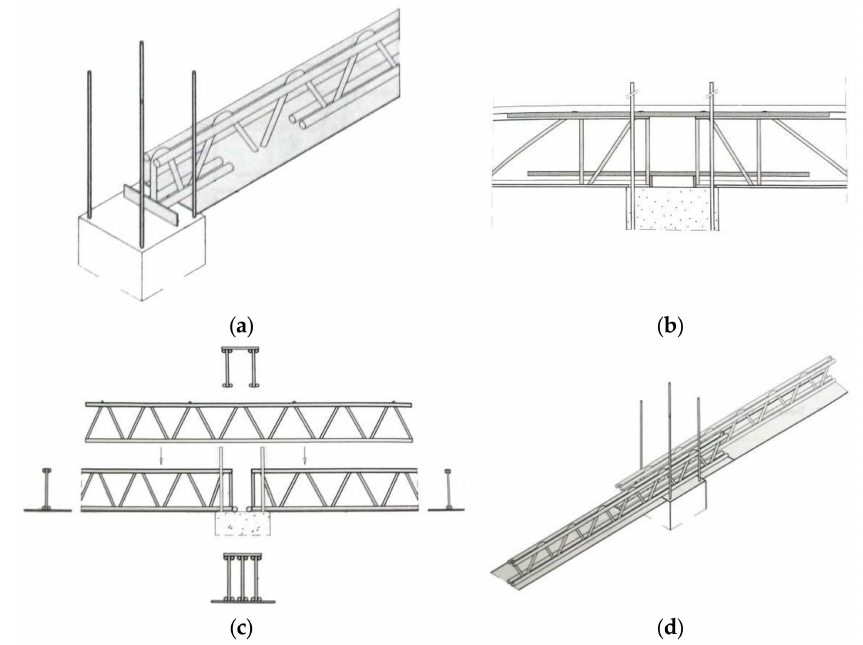
Figure 2. Connection typology at the beam-to-column joint: ( a ) transversal steel plate welded to the rebar welded to the bottom steel plate; ( b ) added top and bottom rebars; ( c ) added bi-planar truss; ( d ) two overlapping lattices positioned